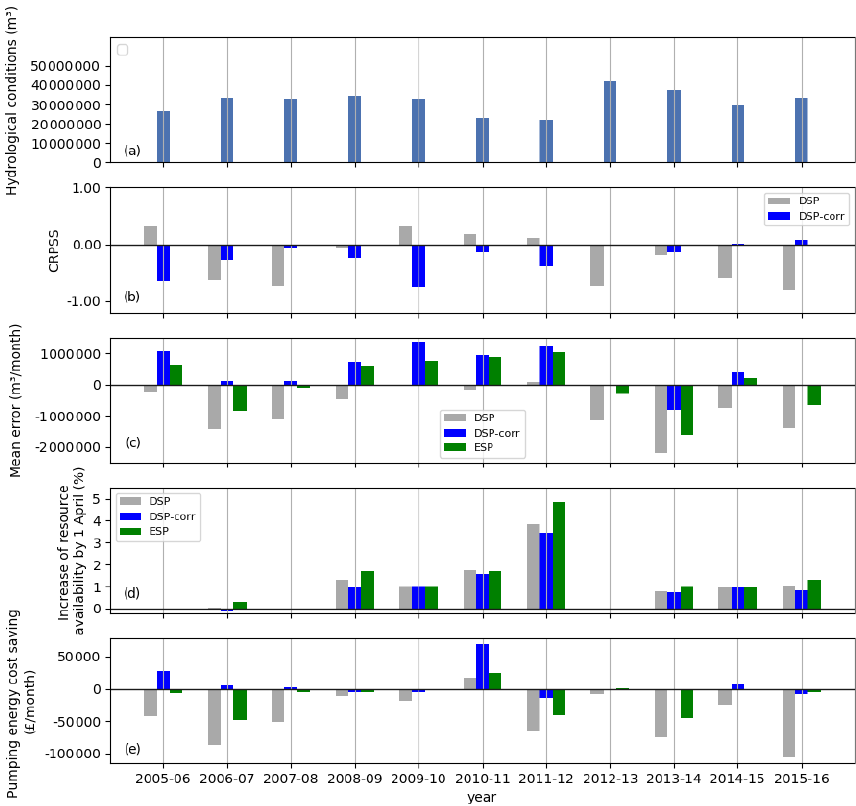
Figure 6. Year-by-year (a) hydrological conditions (total observed inflows + initial storage) and forecast skills of the meteorological forcing: (b) CRPSS and (c) mean error. (d) Increase of resource availability and (e) pumping energy cost savings of the real operation system informed by the dynamical streamflow prediction (DSP), the bias-corrected dynamical streamflow prediction (DSP-corr) and the ensemble streamflow prediction (ESP) for the resource availability prioritized (rap) scenario. Please note that ESP is not shown in (b) as it is the CRPSS